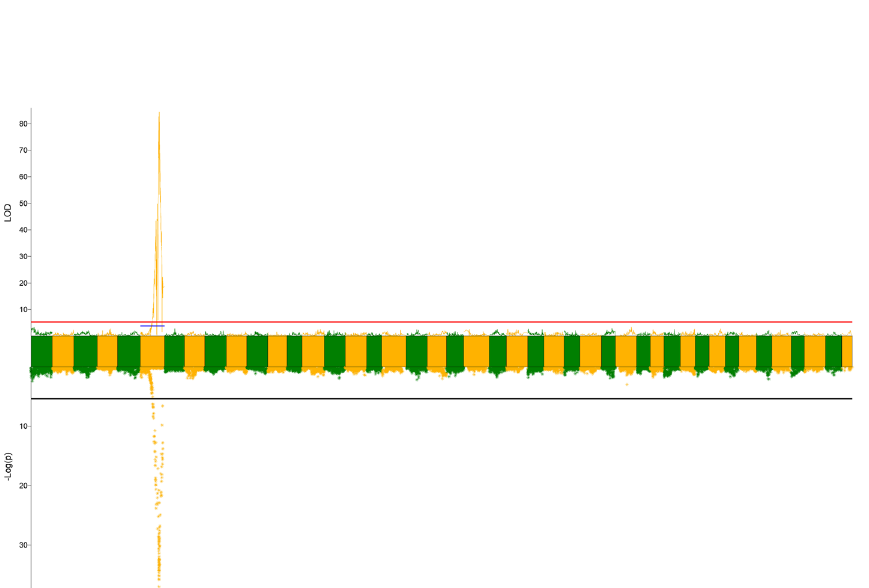
Figure 3. QTL mapping and association analysis of sex in F. chinensis . The top half of figure indicated the LOD of QTL analysis, the red and blue lines indicate the genome-wide and chromosome-wide significance thresholds, respectively. The bottom half of figure indicated –Log( P ) of association analysis, the black line indicated the threshold modified by bonferroni